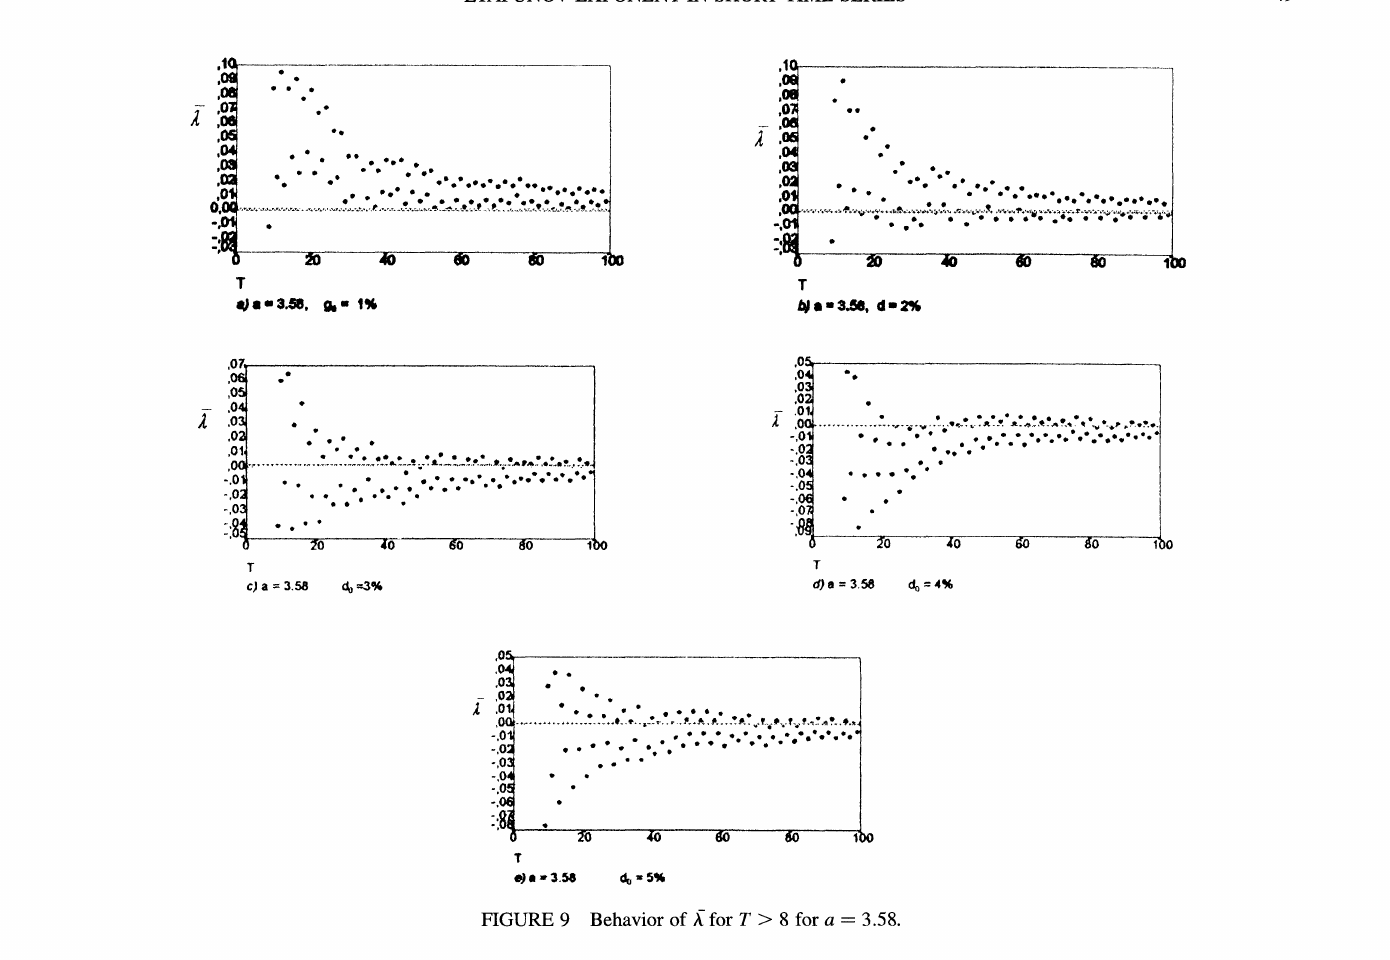
FIGURE 9 Behavior of X for T > 8 for a